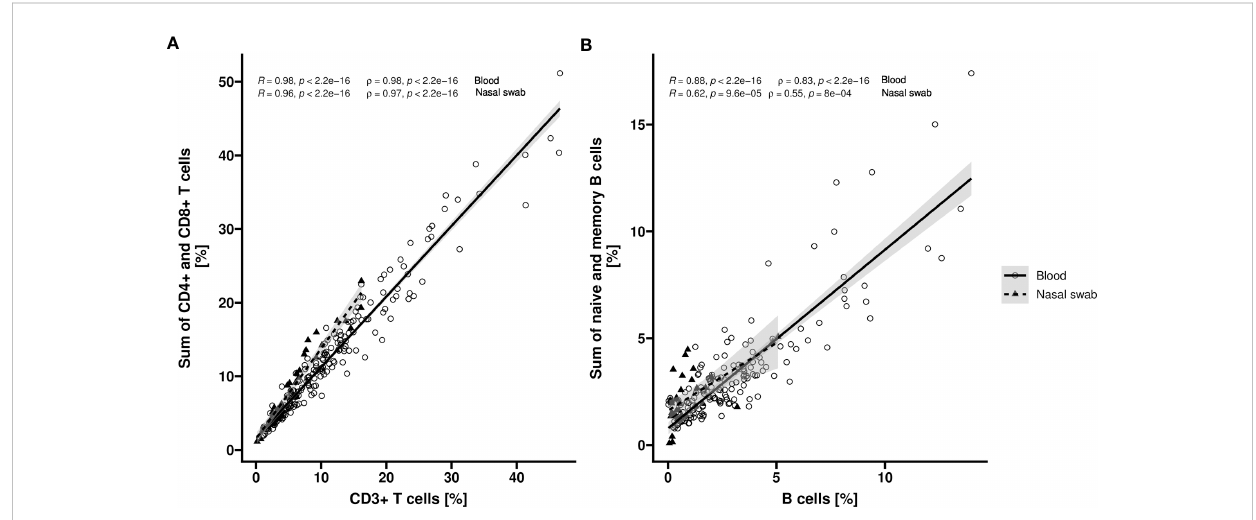
FIGURE 4 Correlation of T or B cell populations in blood and nasopharyngeal swabs. Relative counts (%) of CD3 + , CD4 + and CD8 + cells respective overall, memory and naïve B cells are determined by epigenetic qPCR for whole blood (Blood) and nasopharyngeal swabs (Nasal swab) from COVID-19 patients or healthy volunteers. Scatter plots show the correlation of CD3 + T cell count and sum of CD4 + and CD8 + T cell count (A) (n = 213 [Blood] or n = 40 [Nasal swab]) or total B cell count and sum of naïve and memory B cell count (B) (n = 166 [Blood] or n = 34 [Nasal swab]). Datapoints for blood samples are indicated by circles (solid line) and for nasopharyngeal samples by triangles (dashed line). Corresponding regression lines (y~x) are shown as solid lines inclusive 95% con fi dence interval (grey area). Pearson (R) and spearman (rho) coef fi cients with corresponding p values are shown in